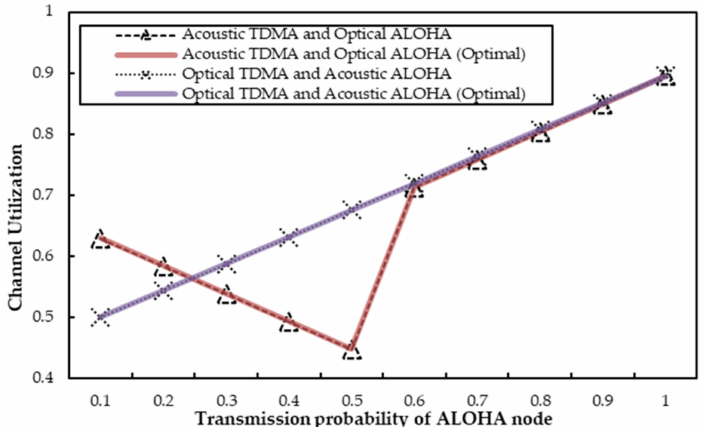
Figure 7. Channel utilization when one agent coexists with one ALOHA node and one TDMA node, which have fixed R and variable q